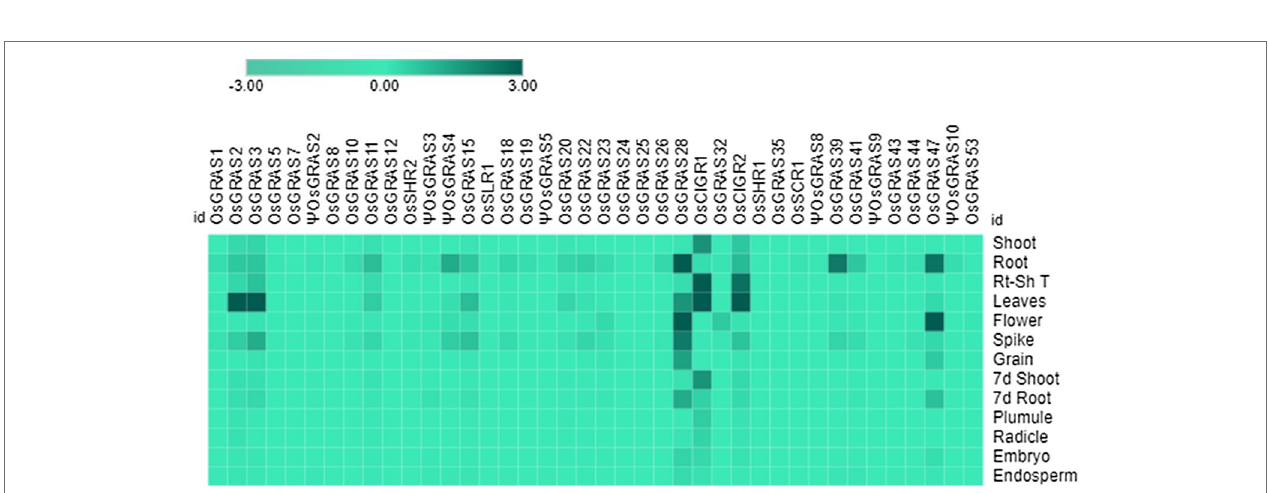
FIGURE 7 | Spatial regulation of OsGRAS genes. The native expression pattern of GRAS genes was studied in 13 different developmental tissues of rice plant. Majority of the genes were downregulated with some of them getting upregulated in mature vegetative and reproductive tissues. The list of the genes expressed in each tissue is mentioned in the boxes beside them. The figure has been adopted from Saha et al. (2017).